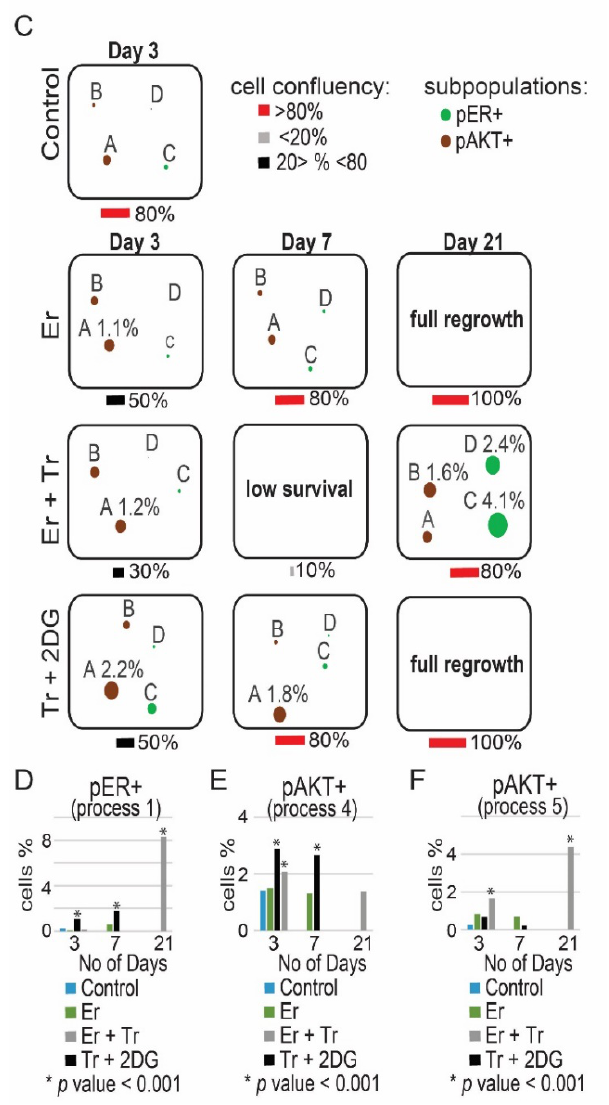
Figure 4. Map of the evolutionary trajectory of MDA-MB-468 cells revealed a switch in signaling state following partial treatments. MDA-MB-468 cells were treated with Er monotherapy/combination of drugs (Er + Tr, Tr + 2DG) for 72 h and allowed to regrow. Then CSSS analysis of single-cell flow cytometry data was performed to map subpopulations that expand in response to different treatments. Cell-specific signaling signature (CSSS) was assigned to each cell which divided the tumor mass into distinct cellular subpopulations. Subpopulations of cells with pAKT+ and pER+ processes, comprising more than 1% in any of the experimental conditions, are presented and quantified. ( A ) 5 unbalanced processes, as identified by the analysis, with the central proteins (those having most significant G values, representing the extent of the participation of a protein in each process) are shown. Proteins colored black are anti-correlated with those colored grey. ( B ) Cells with the same set of unbalanced processes (CSSS) are grouped into subpopulations as represented by different barcodes. Active processes are labeled by either black or grey colors. Each barcode (subpopulation) is then color-coded and presented in ( C ). Proteins labeled in black in ( A ) are induced in black processes ( B ). Proteins labeled in grey in ( A ) are induced in grey processes ( B ); ( C ) The evolution of each subpopulation was then followed over time. The size of the circle represents the percentage of each subpopulation; ( D – F ) Overall percentage of pER+ and pAKT+ cells was quantified for each treatment. Quantification of the subpopulations was performed using at least ~30,000 cells from each